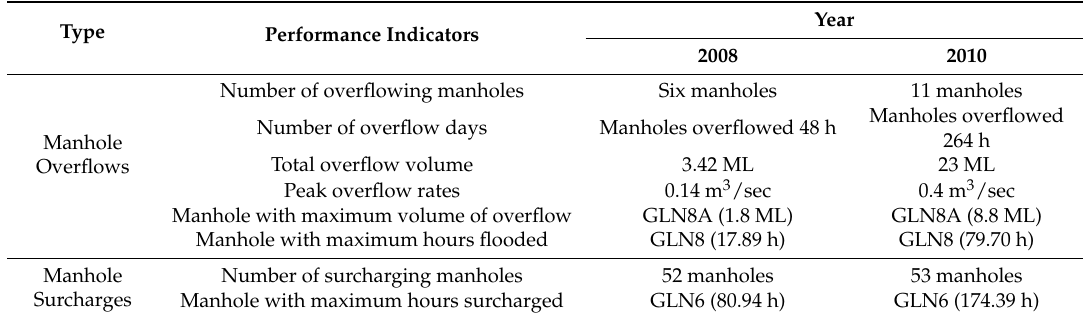
Table 4. Sewer network performance indicators for a dry (2008) and a wet (2010)